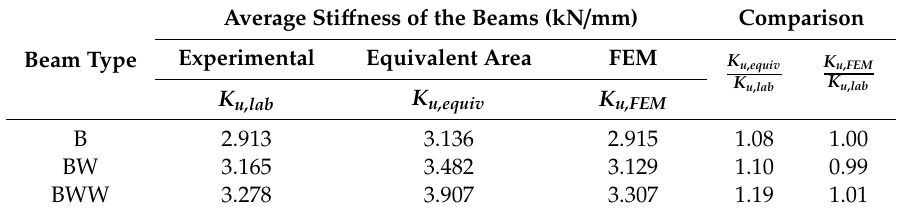
Table 5. Comparison of the beams’ sti ff